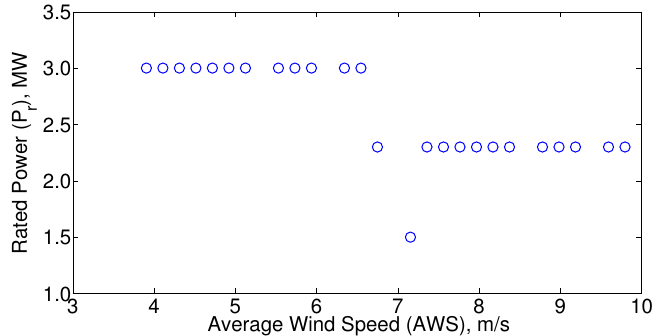
Figure 5. Rated powers of turbines that provide the lowest values of the minimized cost of energy (COE) for different